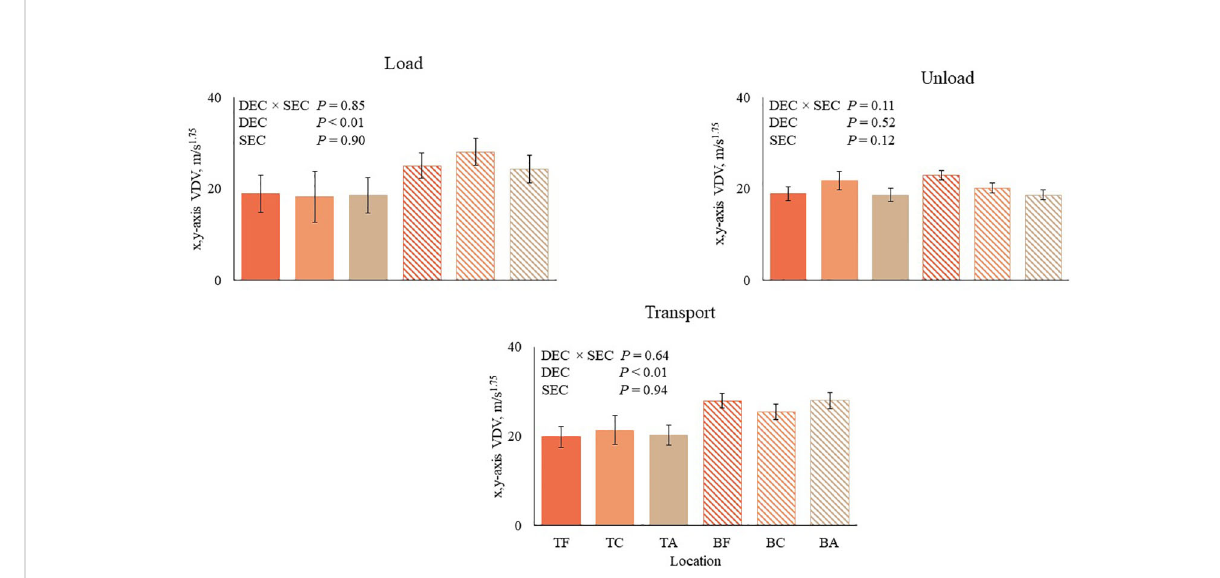
FIGURE 3 Weighted x,y-axis vibration dose value (VDV) experienced by pigs transported within two decks (DEC; T, Top; B, bottom) and three sections (SEC; F, fore; C, center; A, aft) located within two trailers during loading, transport, and unloading. Two trailers transported two daily market- weight pig loads over 5 consecutive